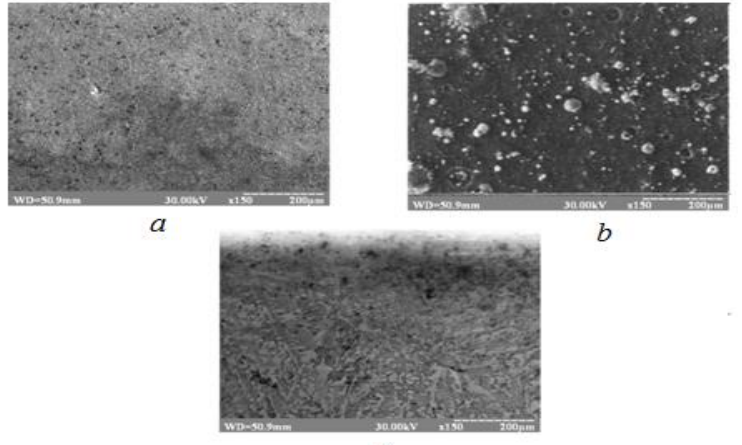
Fig. 7. Microelectronic researches of alloy VK8: а – without coating; b – with coating TiN; c – with the nitrided surface layer